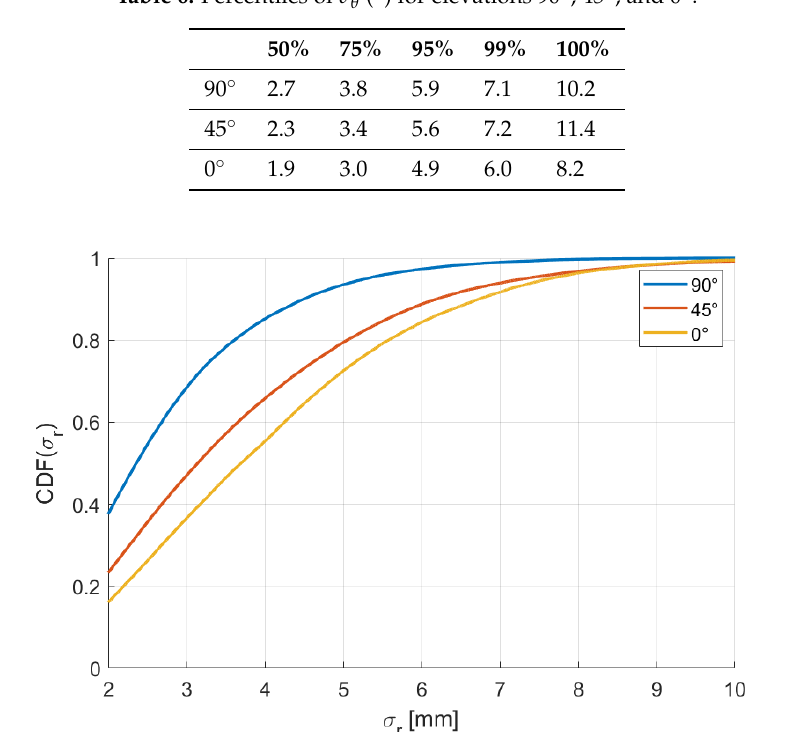
Figure 15. Cumulative distribution functions of σ r for elevations 90 ◦ , 45 ◦ , and 0 ◦ .